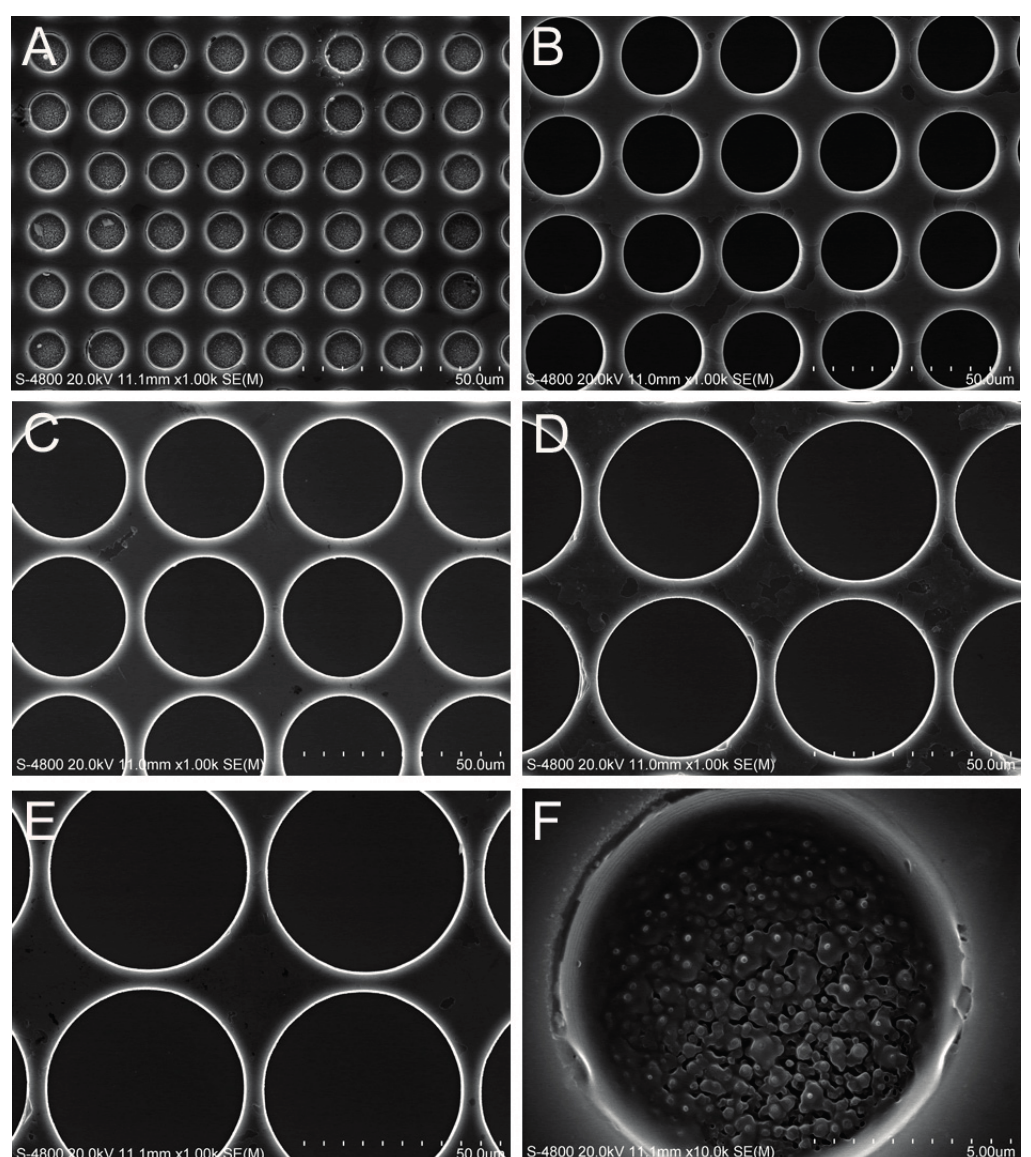
Figure 1. SEM images of the microporous structures with different micropore